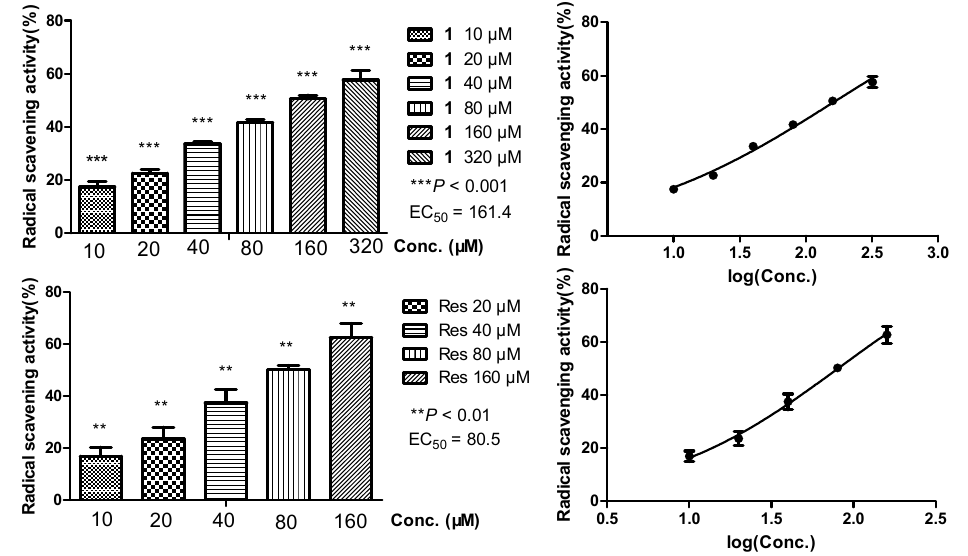
Figure 5. DPPH radical scavenging activity (%) of arahypin-16 ( 1 ) and resveratrol (Res).